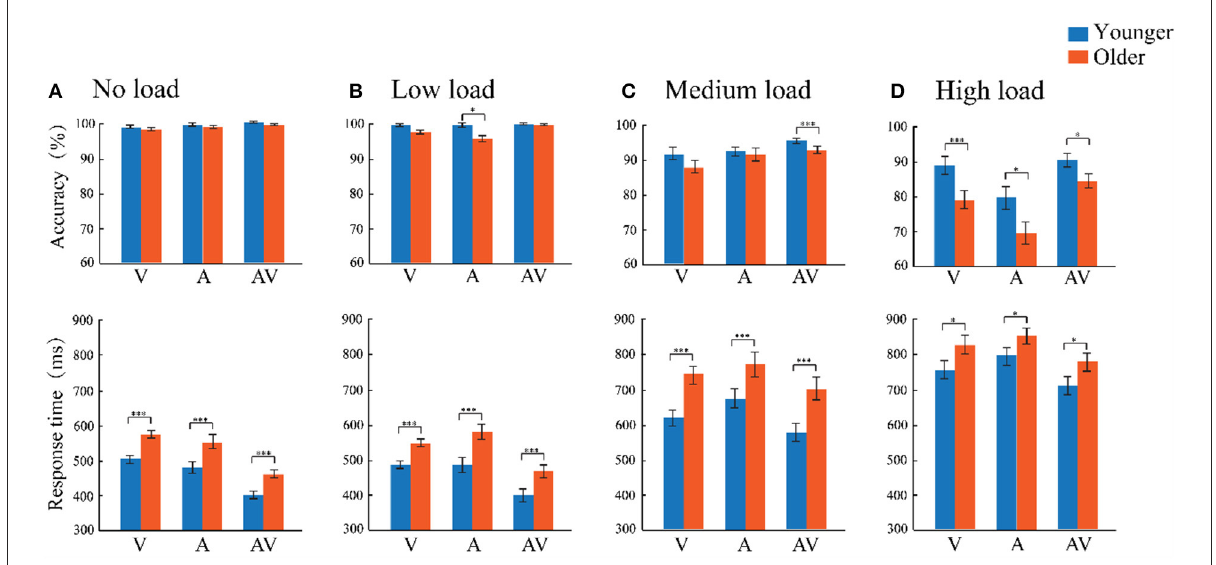
FIGURE2 (A–D) Comparison of the accuracy and response time between the older adults (orange) and younger adults (blue) for the three stimulus types (A, V, and AV) under both the no-, low-, medium-, and high-attentional load conditions. The standard error of the mean (SEM) was also presented. * p ≤ 0.05, *** p ≤